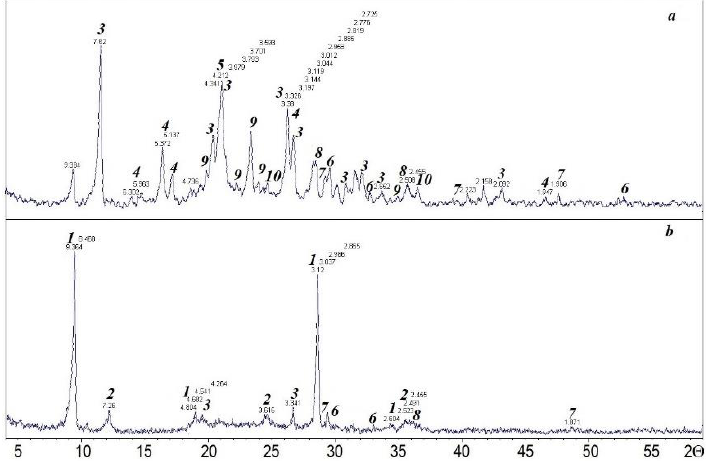
Figure 3. XRD pattern of the clinker after roasting at 350 °C ( a ) and of the leaching residue ( b ). Numbers indicate reflexes: 1—talc; 2—lizardite; 3—pyracmonite; 4—ammoniojarosite; 5—goethite, 6—pyrrhotite; 7—pentlandite; 8—magnetite; 9—nickel sulfate; 10—chalcocyanite.